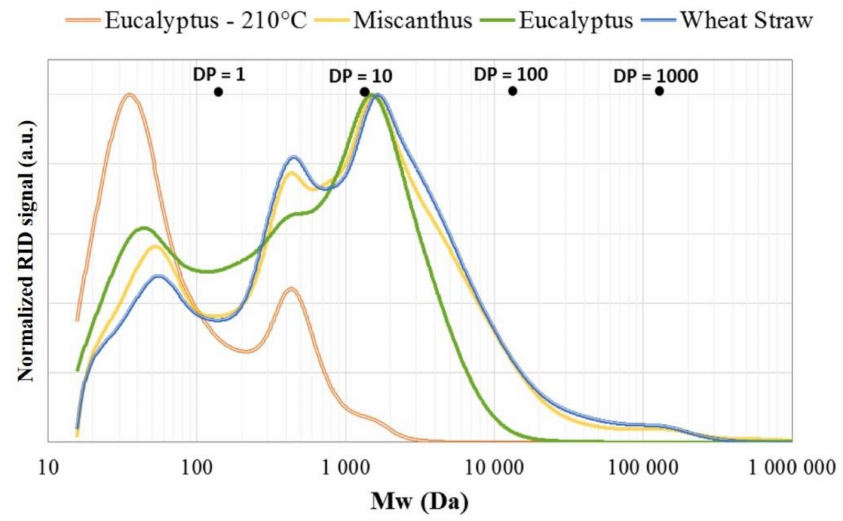
Figure 3. SEC analysis of concentrated autohydrolysis liquors. Autohydrolysis liquors were obtained at 190 ◦ C unless otherwise